Question: Give a one-sentence summary of this figure.
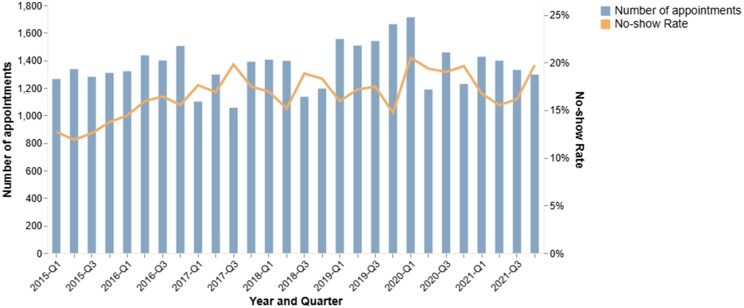
Answer: The number of appointments per quarter for the two MRI machines included in the study, along with the no-show rate.